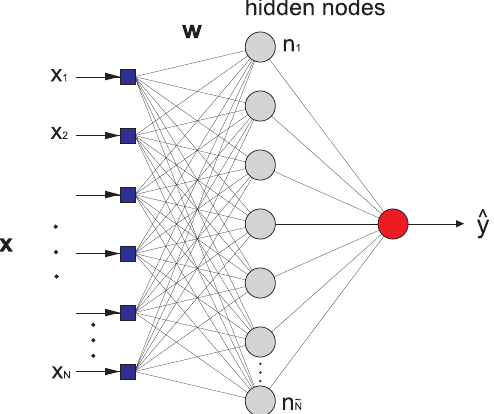
Figure 3. Structure of an MLP neural network, with one hidden